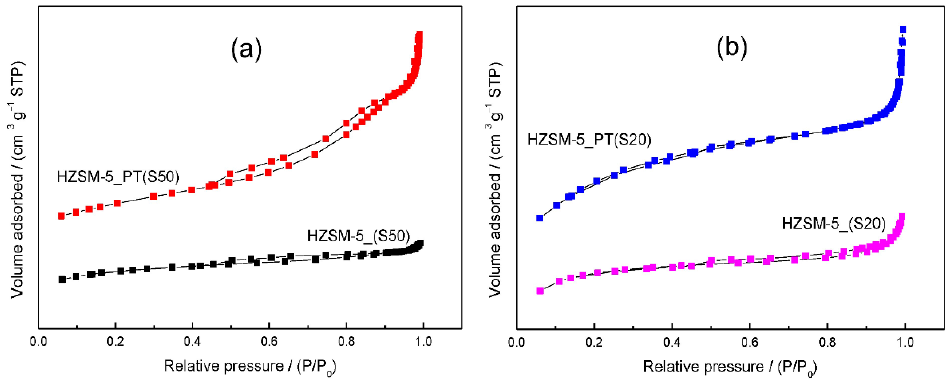
Figure 4. N 2 sorption isotherms of the ZSM-5 zeolites before and after desilication with different Si/Al ratios: ( a ) Si/Al ratio of 50 and ( b ) Si/Al ratio of 20. Reprinted with permission from